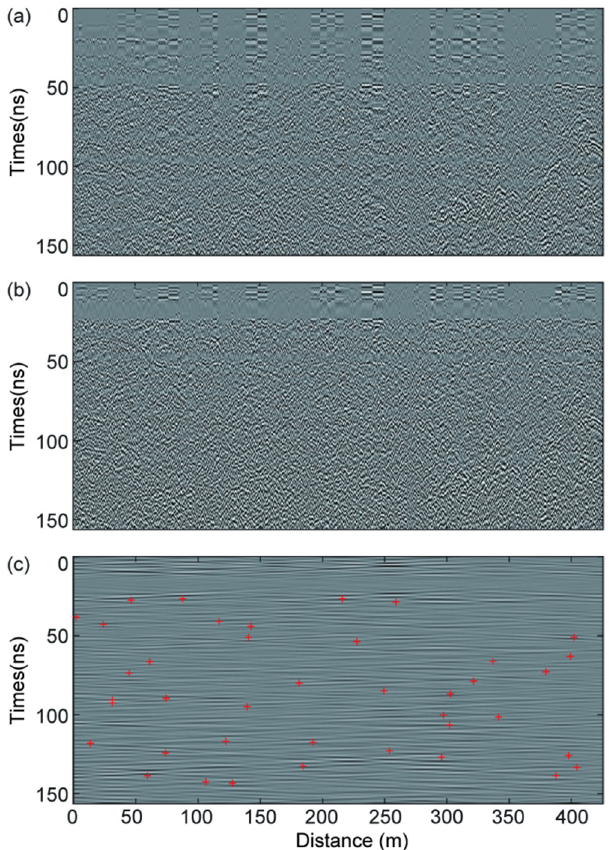
Figure 6. The profile of lunar penetrating radar (LPR) data within the region of 0~150 ns. ( a ) The CH-2A data; ( b ) the CH-2B data; ( c ) the local correlation defined in Section 2.2 for the filtered CH-2A and CH-2B data. The red-cross indicates the vertex position of the diffractions and the white color indicates the maximum value of local correlation.